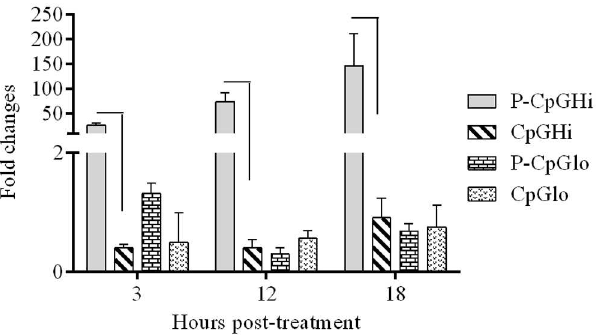
Fig 3. Expression level of IFN- β by stimulation with CpG ODN. Chicken macrophages (six replicates/ group) were treated with encapsulated and solubleCpG ODN. Mean fold expressionof IFN- β in treated groupswere comparedto the cell culture medium treated group. Significance ( P < 0.05) was tested between deliverysystems within a dose and at a given time point. * indicates significantdifference.